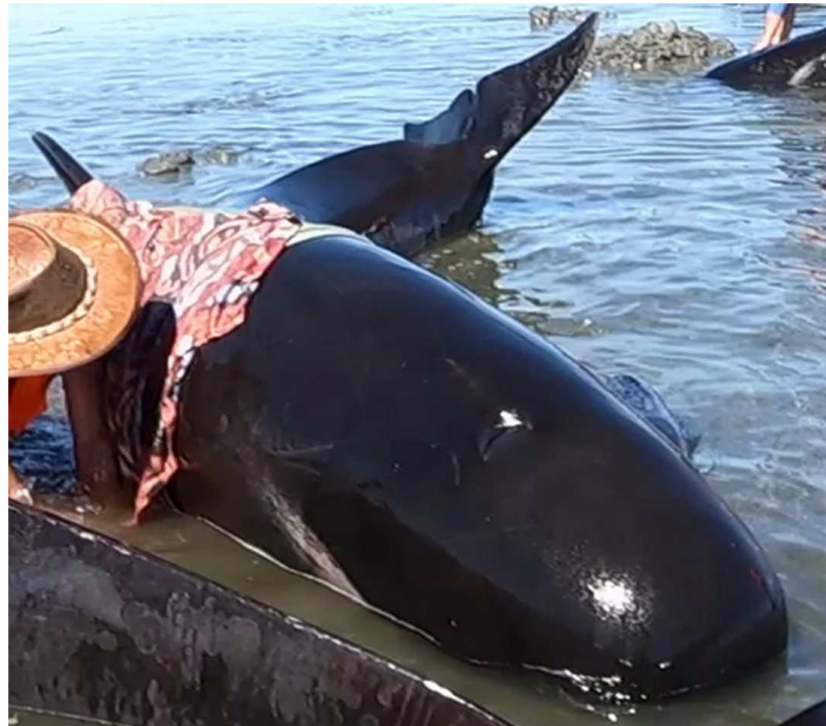
Figure 3. Example of spinal curvature: left lateral curvature of the peduncle in a stranded long-finned pilot whale. Photo credit: Kyle